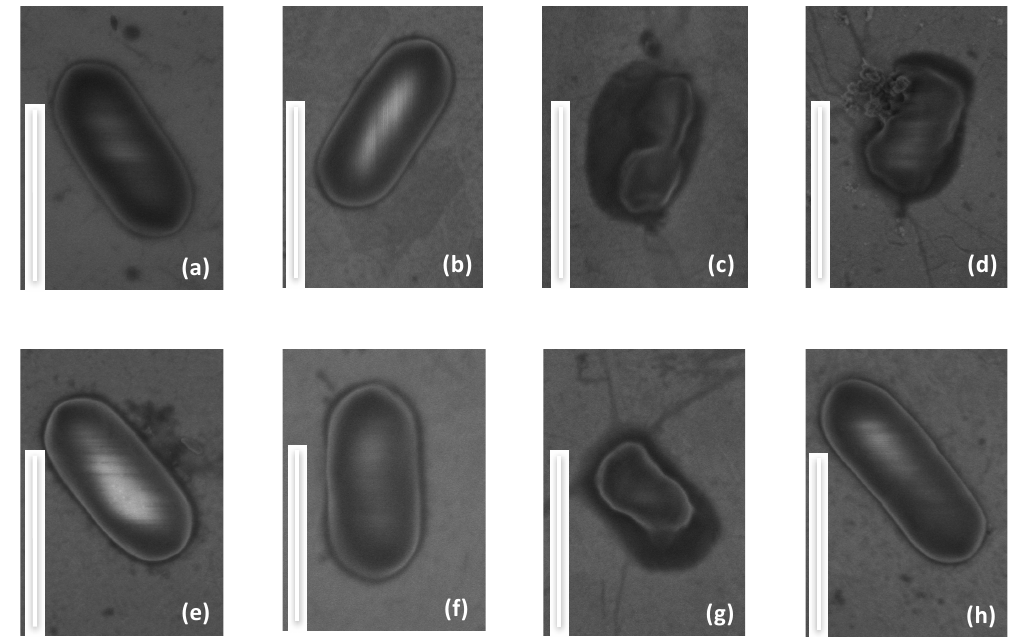
Figure 4. Structural morphology of the Gram-positive bacteria Listeria ivanovii in contact with grafted surfaces compared to bare gold. ( a ) Au, ( b ) MUA, ( c ) [K 3 ]SHa, ( d ) D -[K 3 ]SHa, ( e ) [A 2,6,9 , K 3 ]SHa, ( f ) MUAM, ( g ) [K 3 ]SHa-COOH and ( h ) [A 2,6,9 , K 3 ]SHa-COOH. The scale bare represents 1 µm.